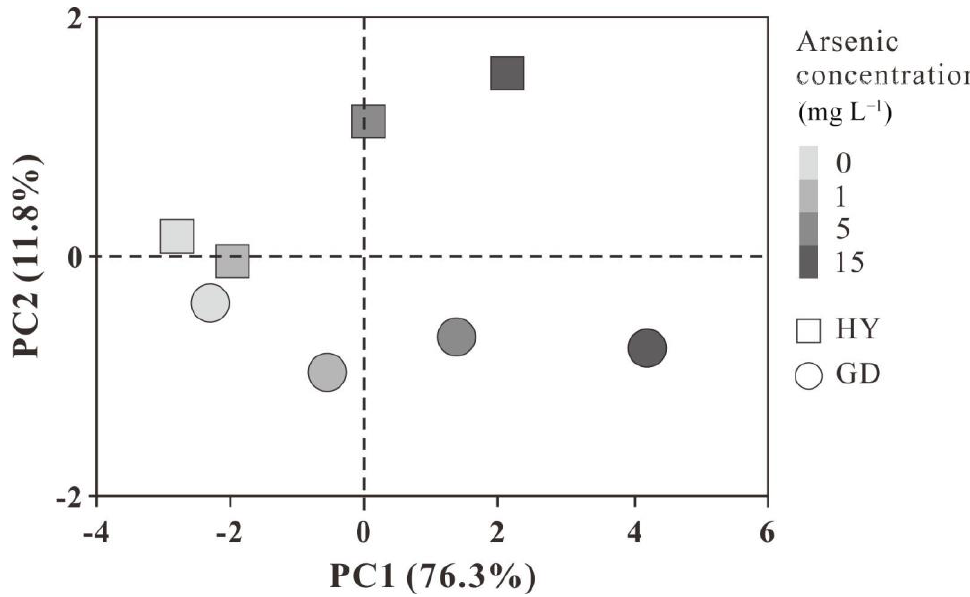
Figure 5. Principal component analysis (PCA) of plant growth parameters under different As con- centrations. As